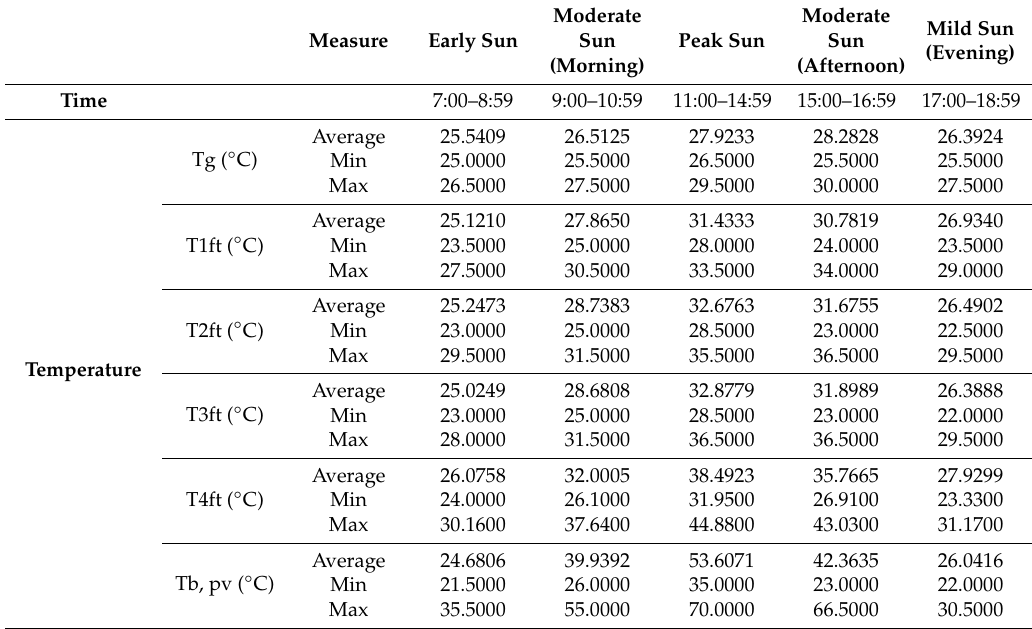
Table 3. Analysis of temperature distributions based on sampling